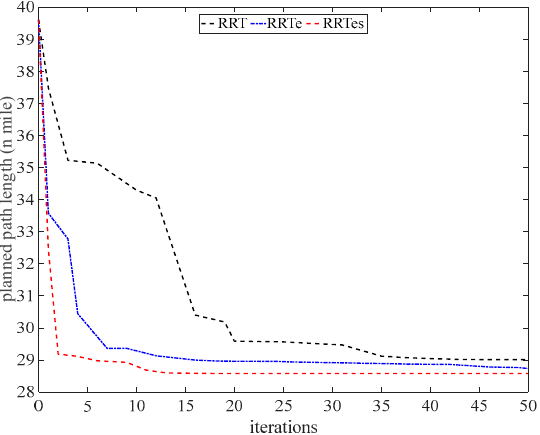
Figure 12. The relationship between iterations and planned path length.